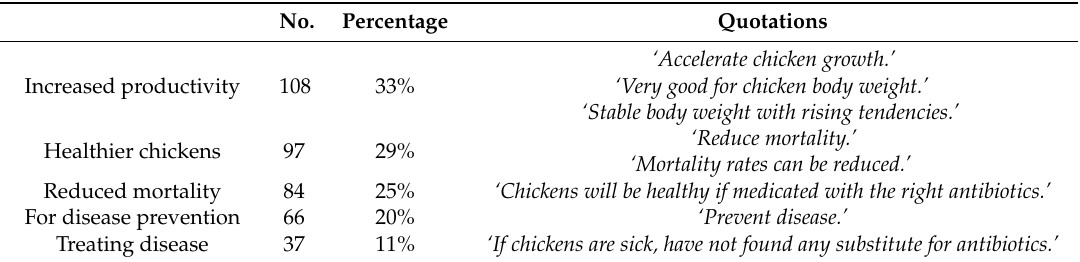
Table 8. Justifications for the economic advantage for antimicrobial use by farmers in a case study into antimicrobial use in broilers in